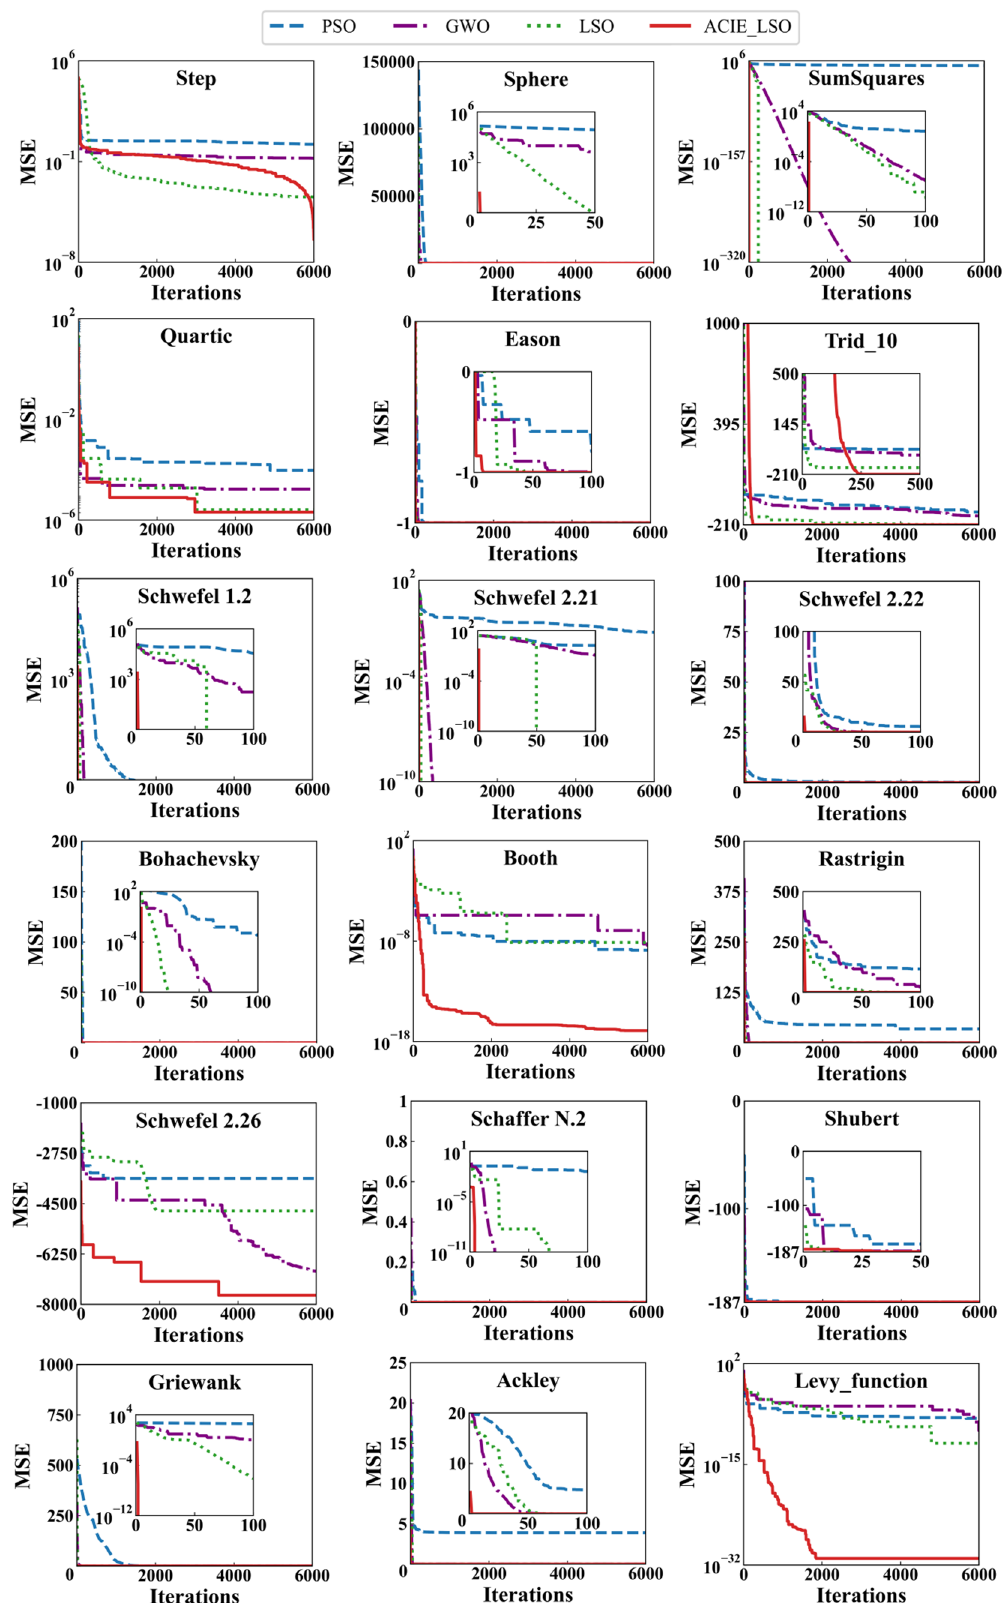
Fig. 3 Iterative convergence curves of four algorithms for solving benchmark